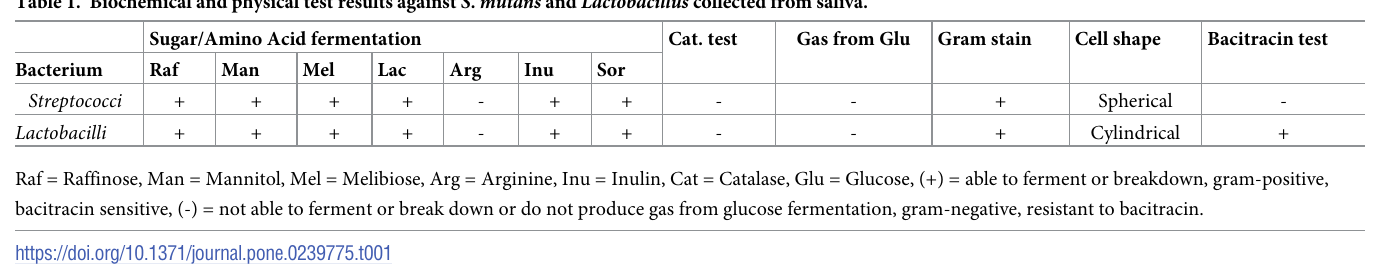
PLOS ONE | https://doi.org/10.1371/journal.pone.0239775 October 9,